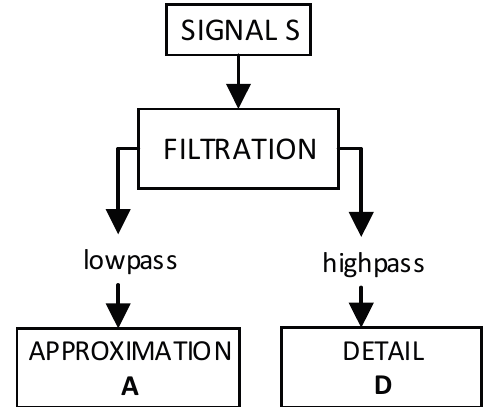
Figure 4. A scheme of wavelet expansion using